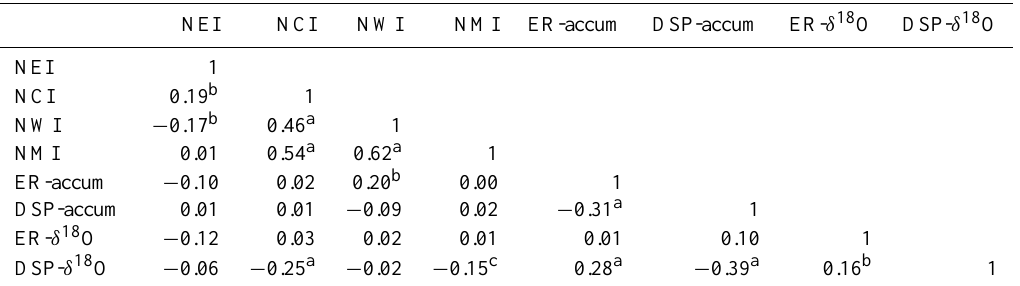
Table 1. Pearson correlation coefficients between the Himalayan ice core records ( δ 18 O and accumulation rate) and the summer monsoon rainfall of the four Indian homogenous rainfall regions north of 21 ◦ N (i.e., NEI: northeastern India; NCI: north-central India; NWI: north- western India; NMI: northern mountainous India) beginning from 1813.